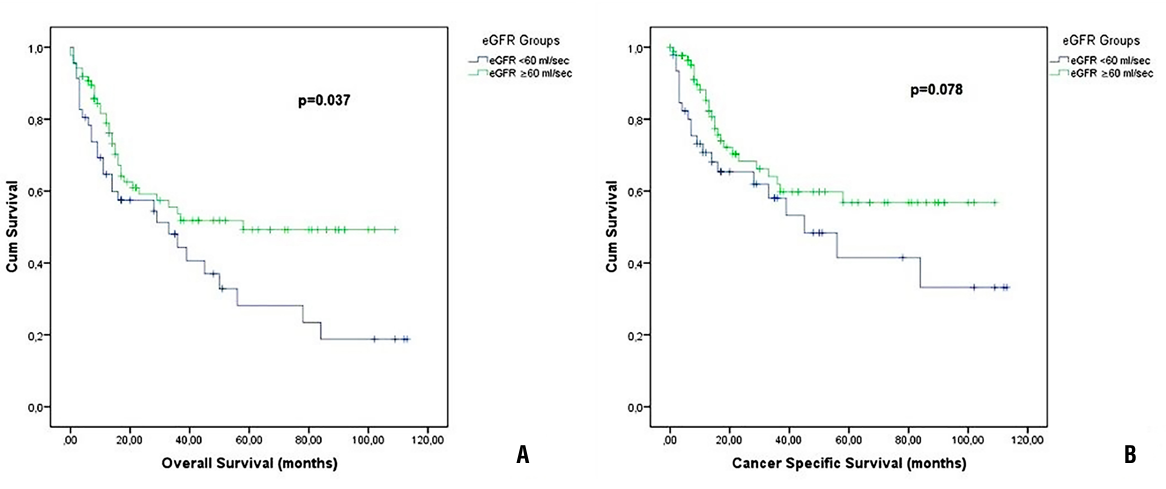
importance of chronic renal insufficiency